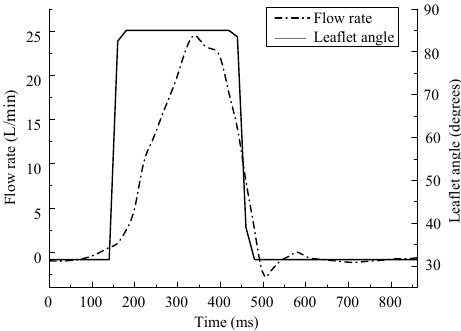
Figure 2. Flow rate and leaflet motion throughout one cardiac cycle.